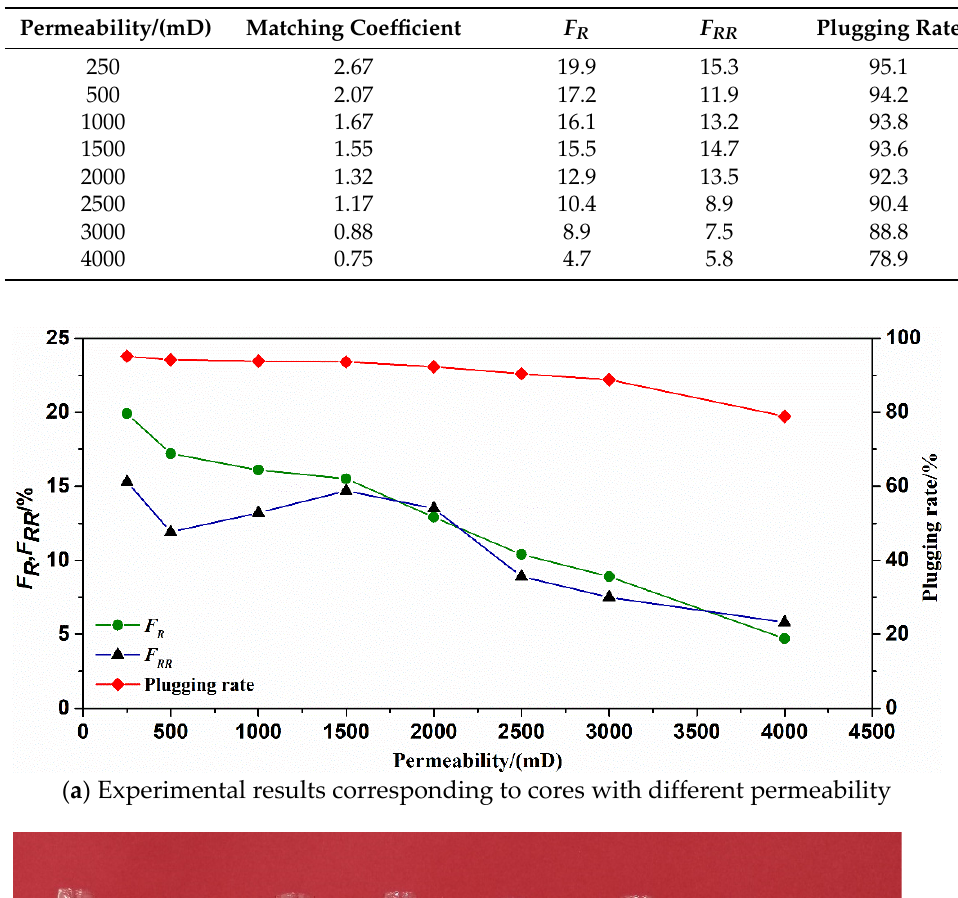
Table 3. The matching results between SMG-mm − and reservoir.